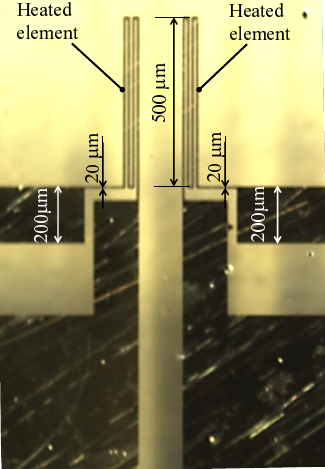
Fig. 3 Photograph of the heated element.